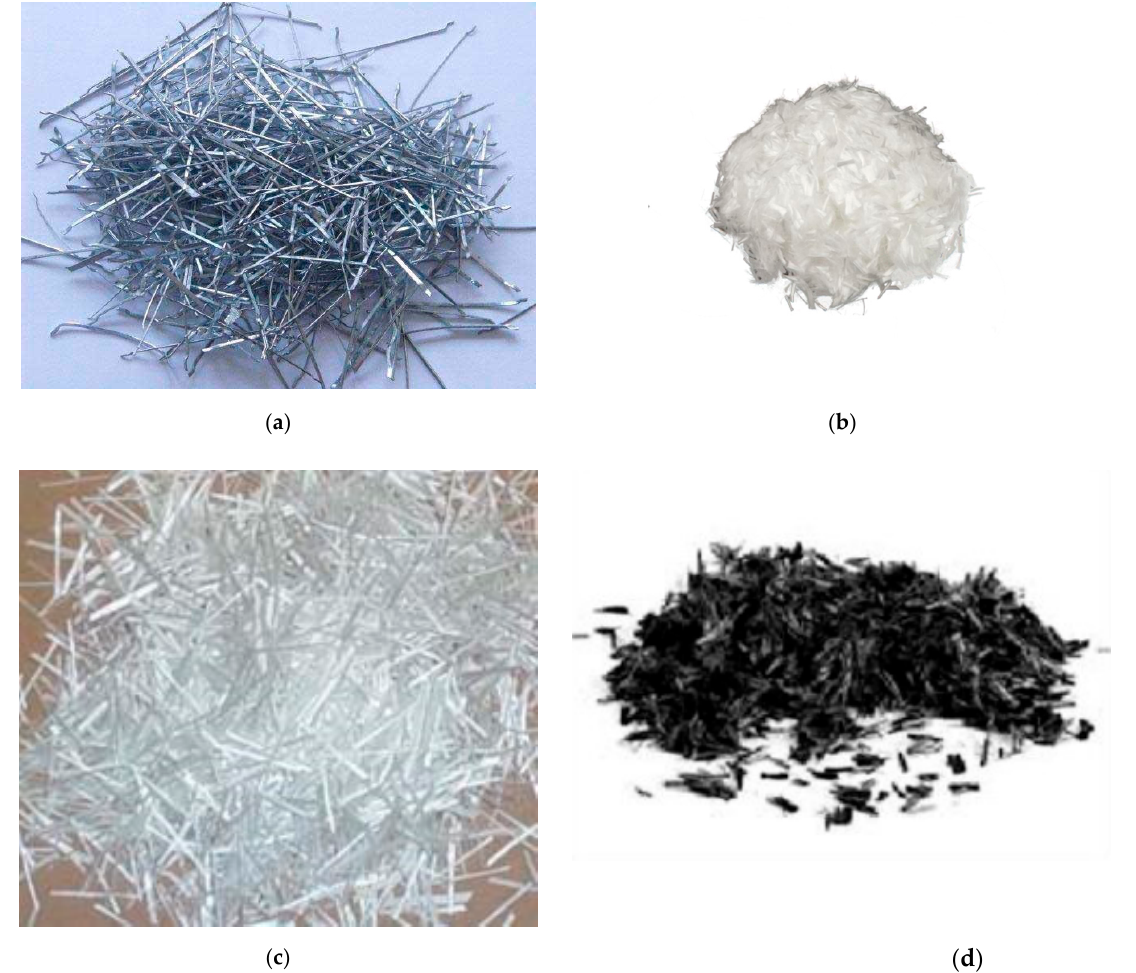
Figure 1. Different fibres: ( a ) Steel fibres; ( b ) Polypropylene fibres; ( c ) Glass fibres; ( d ) Carbon